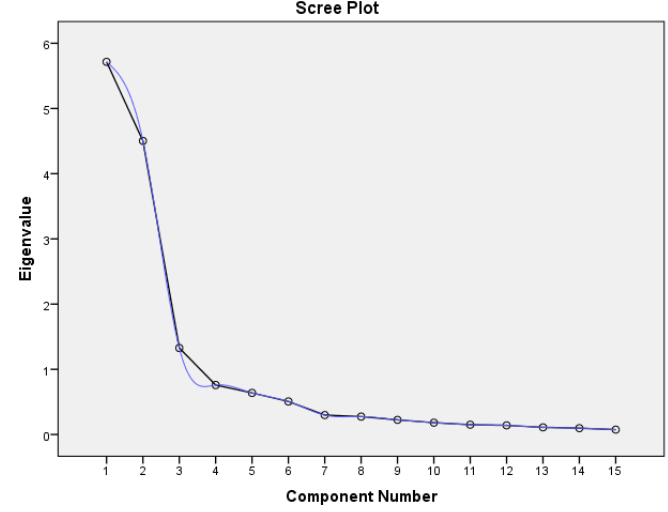
Figure 2. The scree plot begins to flatten from the 9th feature.